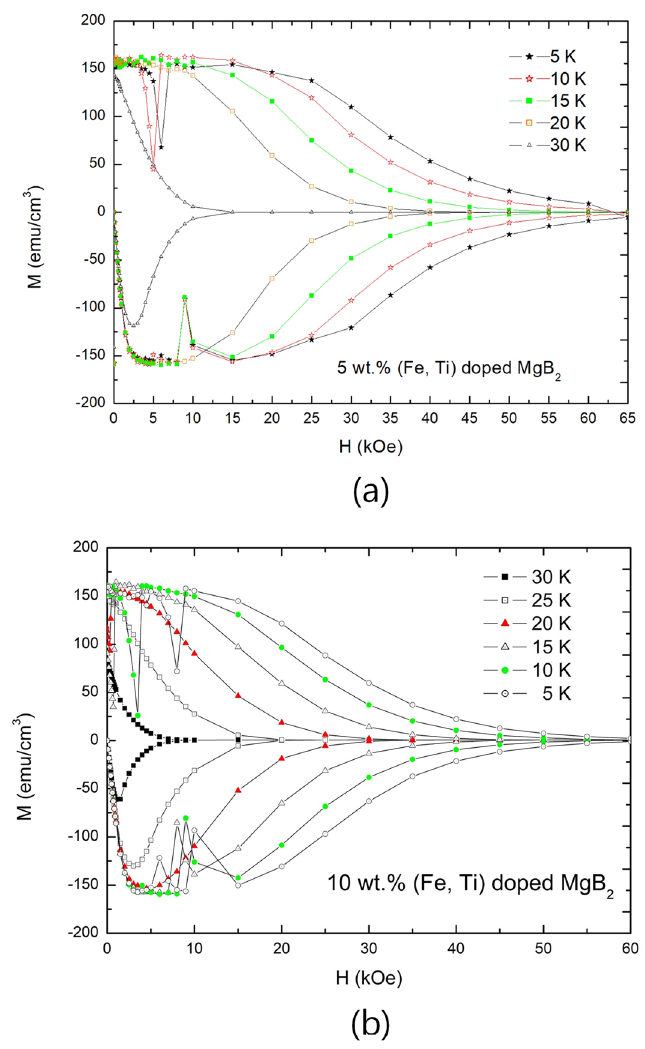
Figure 5. M-H curves of (Fe, Ti) particle-doped MgB 2 superconductors with variation of temperature, which were air-cooled. ( a ) M-H curves of 5 wt.% (Fe, Ti) particle-doped MgB 2 with variation of temperature. ( b ) M-H curves of 10 wt.% (Fe, Ti) particle-doped MgB 2 with variation of